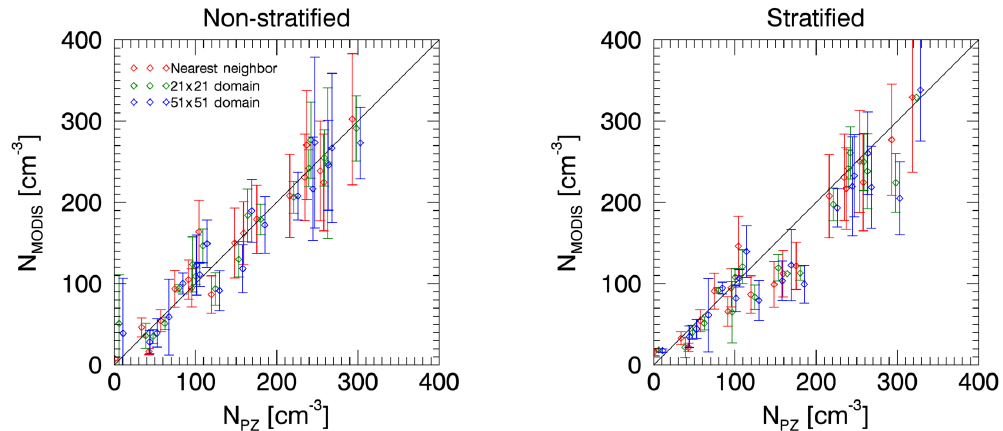
Figure 7. Scatter plot between PZ11-reported airborne and satellite-based derived CDNC estimates, corresponding to the statistics shown in Table 2. Uncertainty for nearest neighbours is estimated using Gaussian error propagation of uncertainties of effective radius and optical depth reported in MODIS C6. Uncertainties for the 21 × 21 and 51 × 51 domains are estimates as the standard deviation of all valid CDNC retrievals within the domains. Note that for each data point the x -axis values of the NN, 21 × 21, and 51 × 51 are slightly offset around the (green) centre value, in order to be able to better visually discriminate the error bars. See Table 1 for terminology regarding “Stratified” and “Non-stratified”. Table 2. Statistics of comparison between PZ11-reported airborne and satellite-based derived CDNC estimates, corresponding to the scatter plots shown in Fig. 7. The columns marked “N” refer to “Non-stratified” case, whereas the columns marked “S” refer to the “Stratified” case. The reported uncertainty is the mean value of the error bars seen in Fig. 7. Domain RMSE Bias Correlation Uncertainty (cm − 3 ) (cm − 3 ) (cm − 3 )